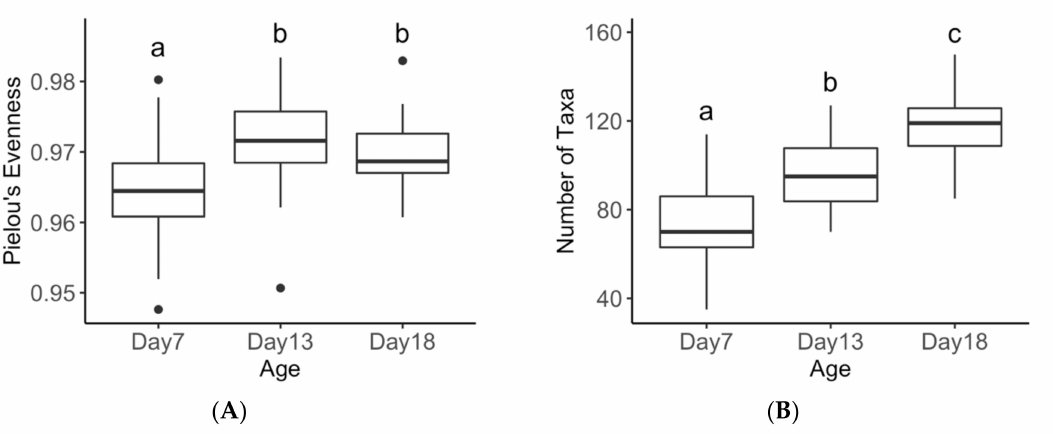
Figure 1. Non-metric multidimensional scaling (nMDS) ordination of faecal bacterial genera from piglets at 7 (inverted triangle), 13 (circle), and 18 (square) days of age along with donor piglets (diamond). All nMDS ordinations attempt to place all samples in an arbitrary two-dimensional space such that their relative distances apart match the corresponding pairwise similarities. Hence, the closer the two samples are in the ordination, the more similar their overall bacterial communities. “Stress” values (Kruskal’s formula 1) reflect the di ffi culty involved in compressing the sample relationship into the two-dimensional